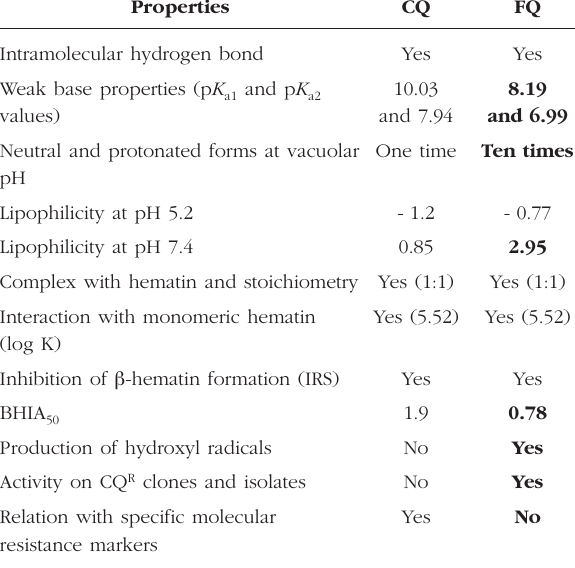
Table II. – Comparative properties of chloroquine (CQ) and ferro- quine